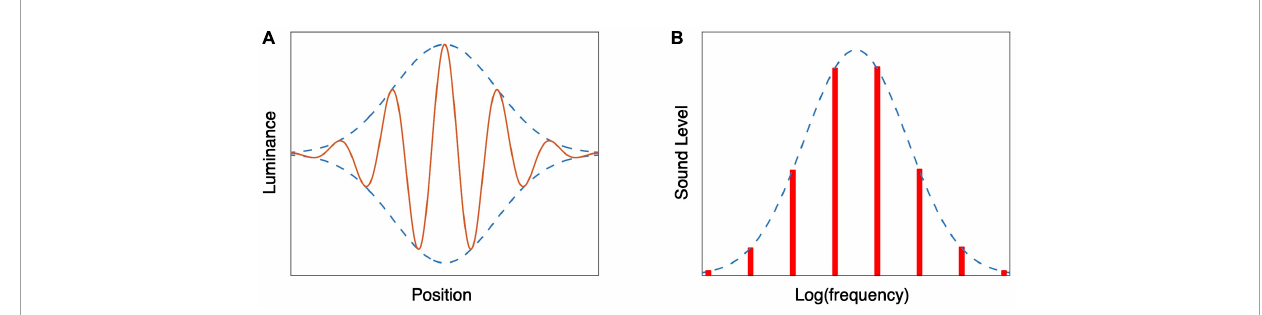
FIGURE2 Schematic representation of stimuli consisting of a Gaussian envelope enclosing a finer structure. (A) A Gabor patch consists of a modulation of luminance by a sinusoid multiplied by a Gaussian. If the phase of the sinusoid is changing, the whole patch seems to move. (B) Shepard tones can be constructed by taking an infinite number of pure tones that are an octave apart and modulating the sound pressure level by a